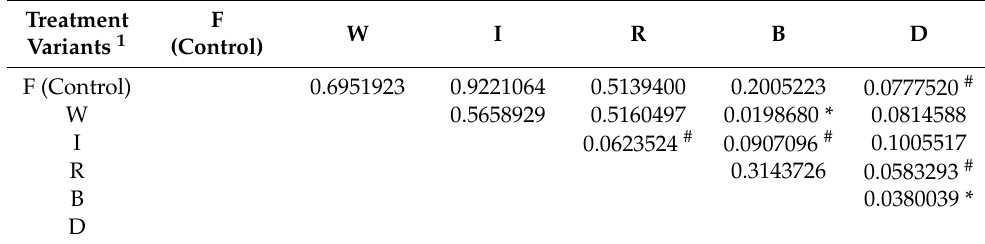
Table 4. Differences between the groups of treatment variants with the same GA 3 pretreatment and different levels of light for seedlings with cotyledons/first true leaves of P. veris (Excel t -test paired analysis).